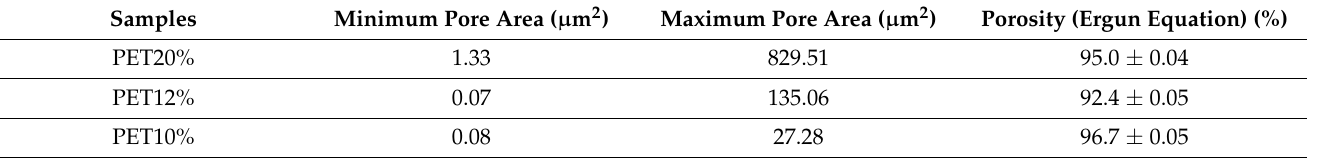
Table 3. Minimum and maximum pore size and porosity for each